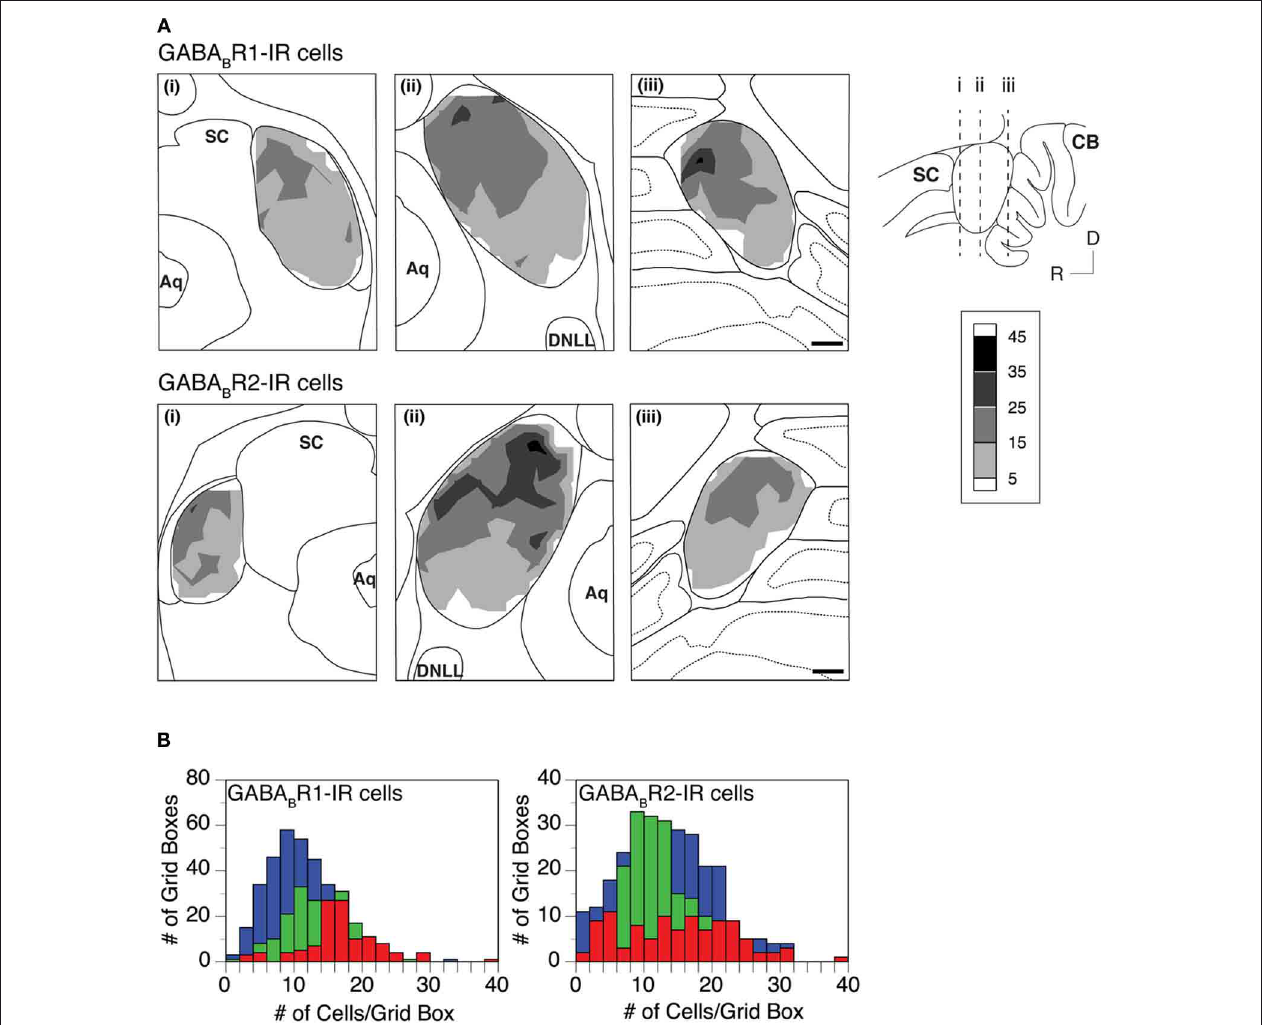
FIGURE 6 | (A) Densities of GABA B R1-IR and GABA B R2-IR cells (top and bottom rows) in the IC. Analyses were conducted on two animals for each subunit. Results in the two rows are from two different animals. In each row, contour plots in three panels show densities of labeled cells in three coronal sections at different rostrocaudal locations as indicated in the inset. A density of labeled cells represents the total number of immunoreactive cells in a